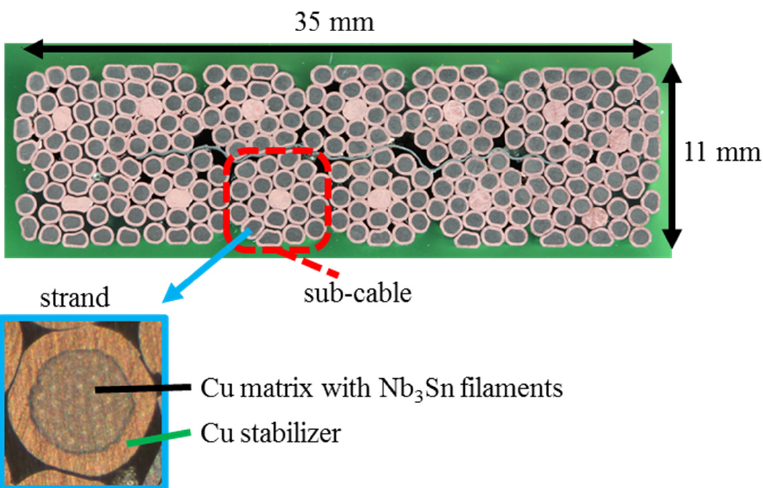
Figure 1. Cross-section of the superconducting Nb 3 Sn cable used in the joint manufacture. The strands are plated with chromium in order to avoid sintering among them during the heat treatment of the cables. This cable is heat treated so that the precursors form the superconducting Nb 3 Sn through a solid-state diffusion process [8]. After that, the cable becomes brittle and is able to carry 63.3 kA without losses at 4.5 K and 12.23 T. Such a cable is at the base of the winding of the TF magnet proposed by the SPC. Further details about this and the other components of the conductor can be found in